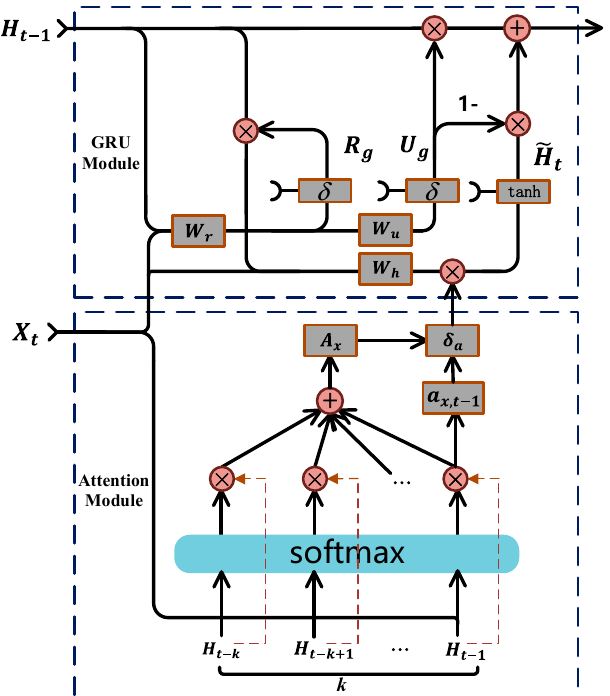
Figure 5. Structure of the a tt ention − GRU model.